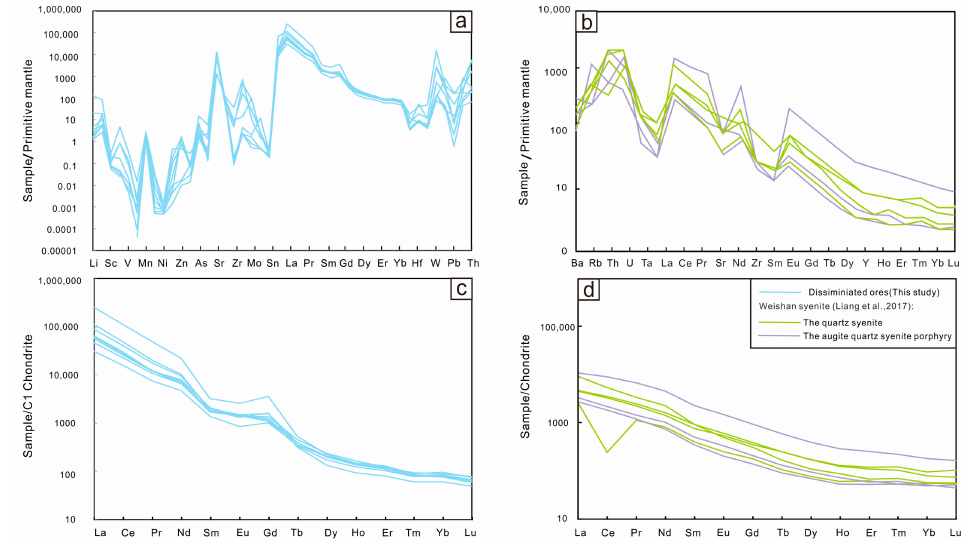
Figure 8. ( a , b ) Primitive-mantle-normalized trace element diagrams and ( c , d ) chondrite-normalized REE patterns of REE ores and syenites from the Weishan REE deposit. ( b , d from [50]; normalizing values are after